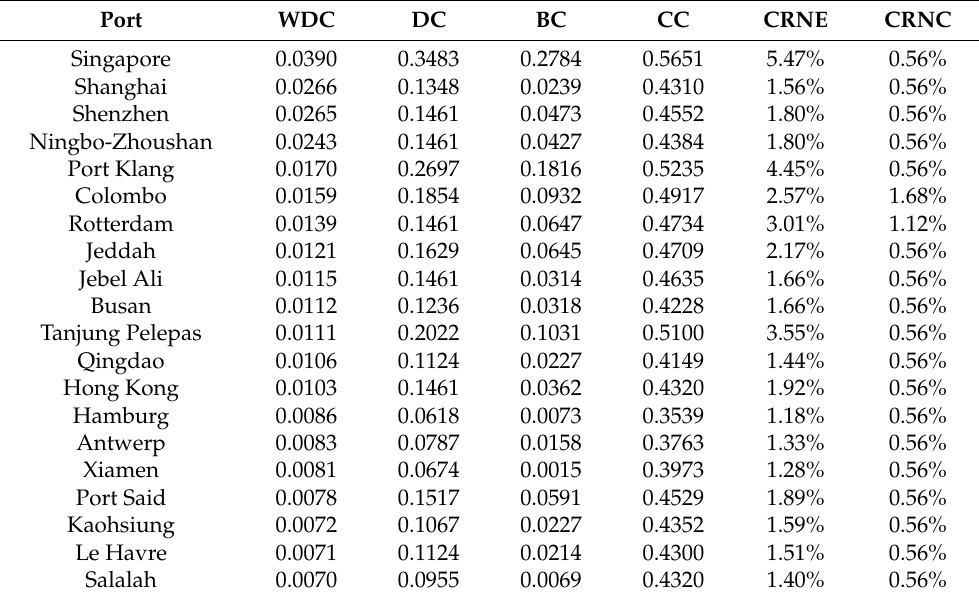
Table 3. The centrality index and vulnerability index of the top 20 ports in terms of